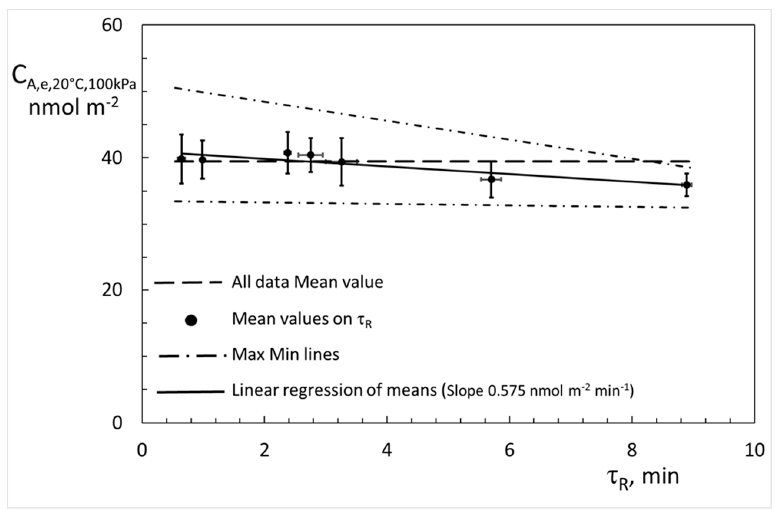
Figure 7. Sensitivity of adsorbed amount per unit area on residence time. Values corrected at 20 °C, 1bar and grouped on τ R